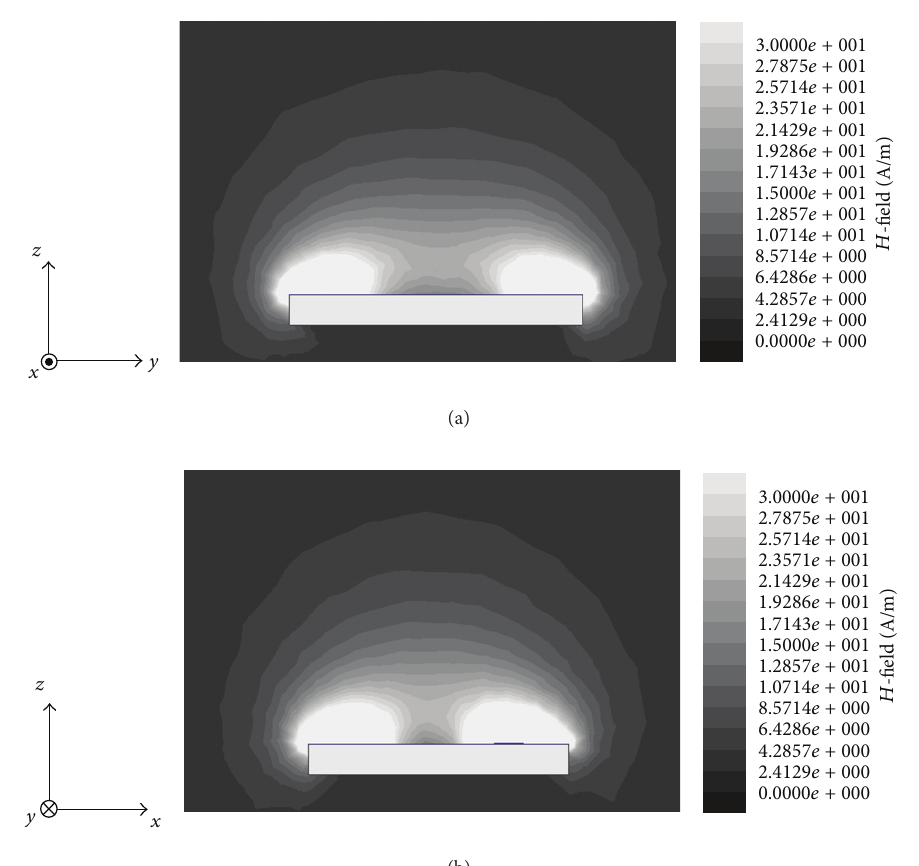
Figure 6: Near-field ( 𝐻 -field) distribution of the proposed loop antenna with the parasitic loop embedded capacitor (800pF); (a) 𝑦𝑧 -plane and (b) 𝑧𝑥